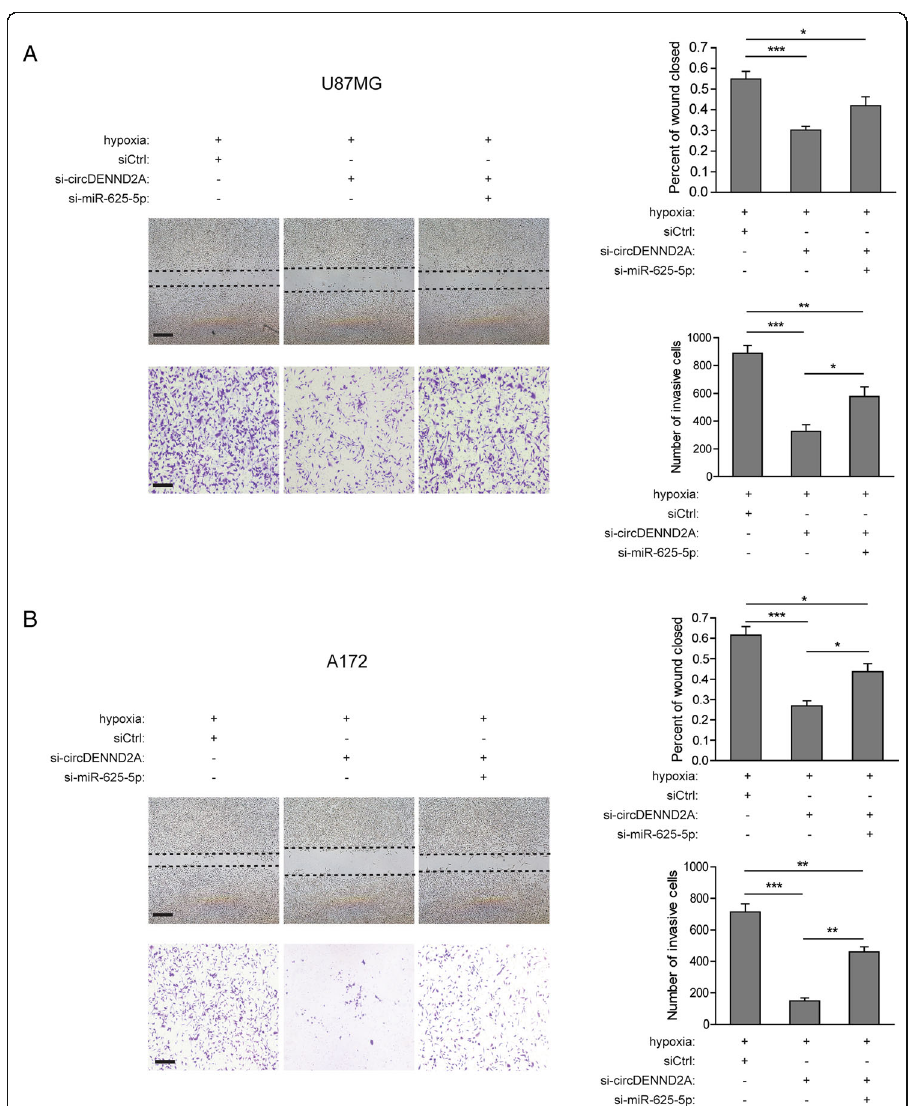
Fig. 4 CircDENND2A enhances the migration and invasion of glioma cells via sponging of miR-625-5p. a and b Left: Representative images from wound healing assays or Transwell assays in hypoxic U87MG and A172 cells with or without knockdown of circDENND2A or miR-625-5p. Scale bar, 100 μ m. Right: Percentage of wound closure or numbers of invasive cells at 48 h after treatment. Data are shown as mean ± SD (three independent repeats). * p < 0.05, ** p < 0.01, *** p <